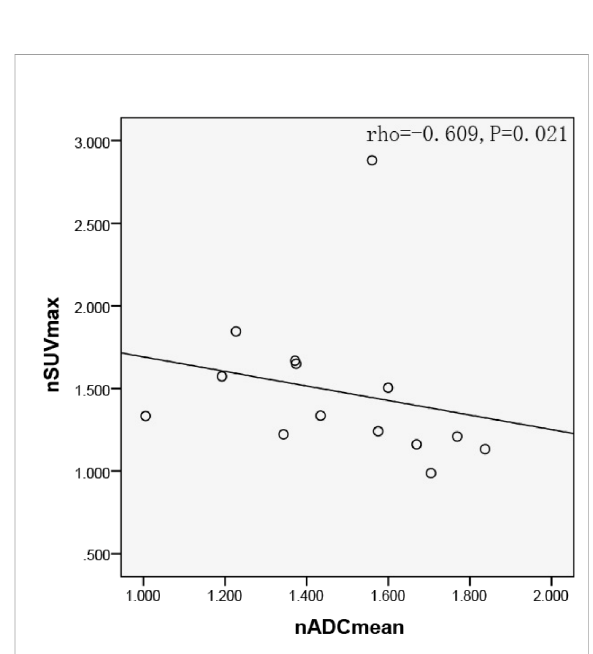
FIGURE 3 Scatter diagram of nSUV max with average nADC. Signi fi cant negative correlation were found between nSUV max and nADC in the solid tumor region (rho=-0.609, P=0.021). SUV, standard uptake value; ADC, apparent diffusion coef fi